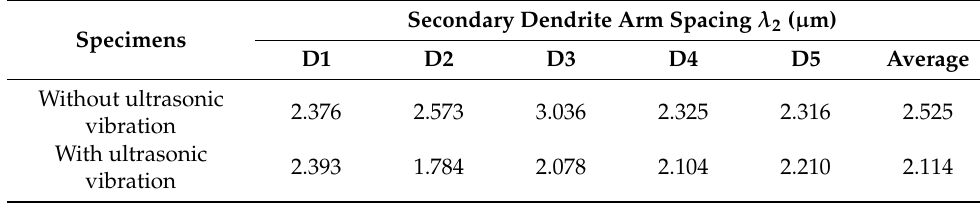
Table 3. Secondary dendrite arm spacing.